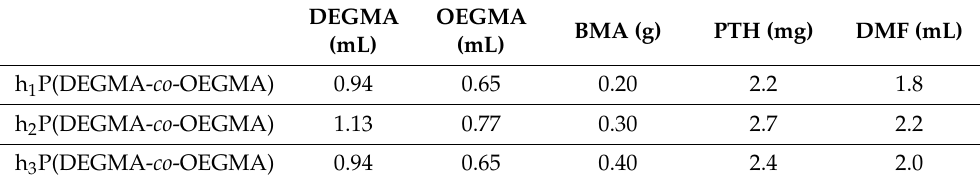
Table 1. Polymerization recipe of three hyperbranched